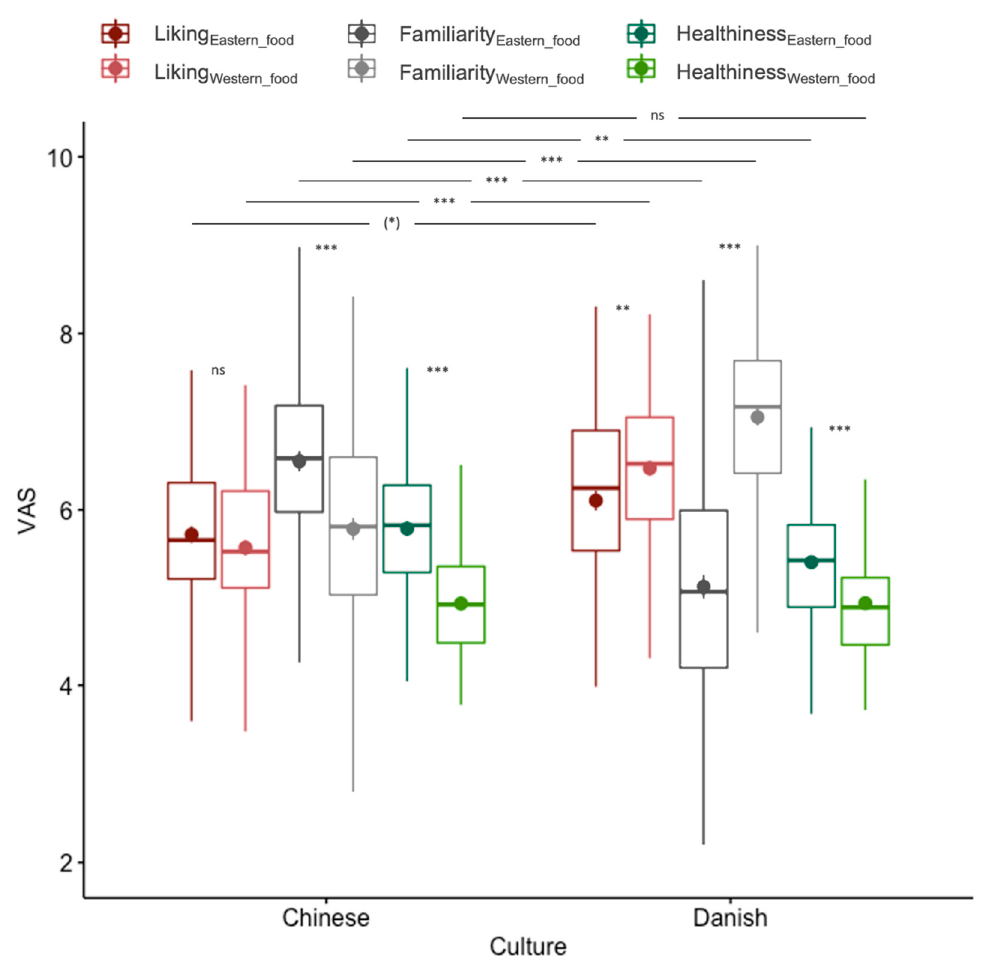
Figure 5. Boxblot of the liking, familiarity, and healthiness visual analogue scale (VAS) ratings of the Eastern vs. Western food items within and between cultures. ns indicates no significance, (*) indicates p < 0.1, ** indicates p < 0.01, *** indicates p < 0.001.